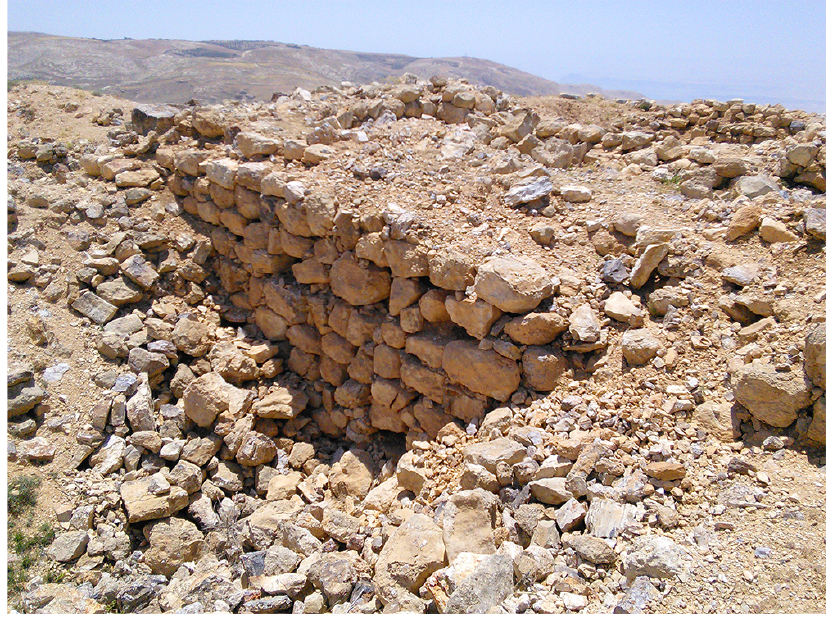
Figure 5: Detail of the architectural remains along the north side of the watchtower at Rujm al-Mukhayyat (photo by S.